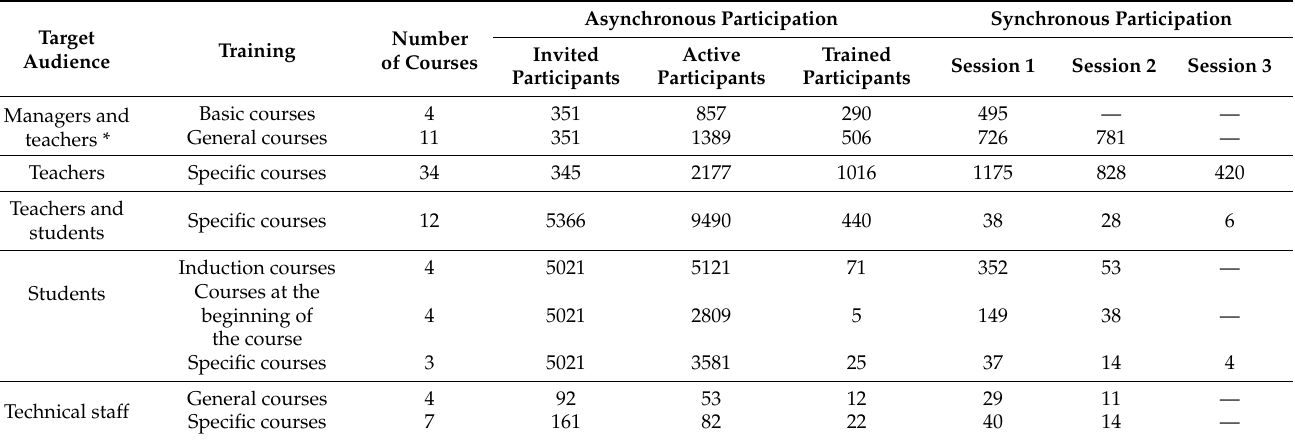
Table 6. Overall results for technological interaction (synchronous and asynchronous).